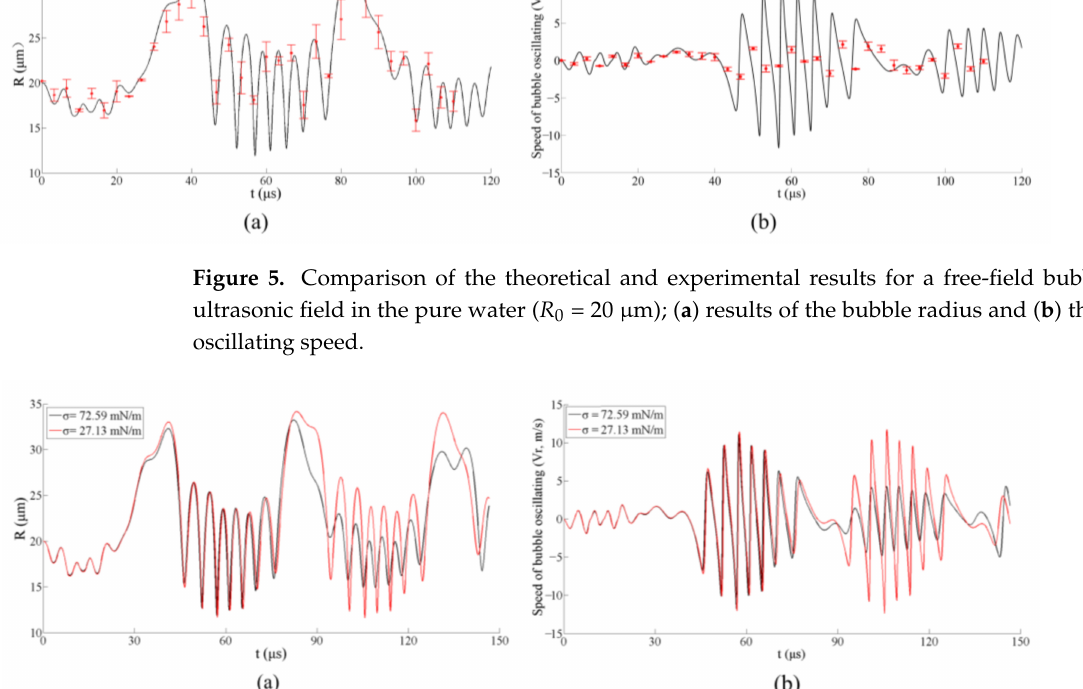
Figure 6. Comparison of the theoretical results for a free-field bubble in the pure water and 1.0 × 10 − 2 mol/L SDS aqueous solution ( R 0 = 20 µ m). ( a ) Results of the bubble radius and ( b ) the bubble oscillating